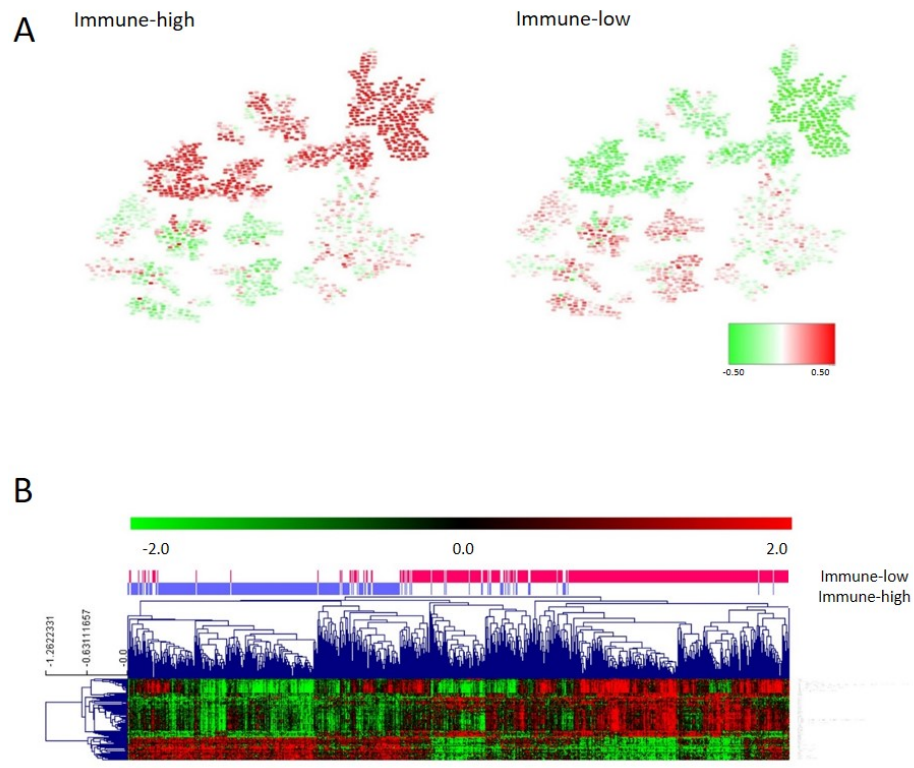
Figure 4. ( A ) Heatmap of the mean gene expression of immune groups in the PGM. Red = overexpressed. Green = underexpressed. ( B ) One hundred differential genes between immune groups identified by SAM.